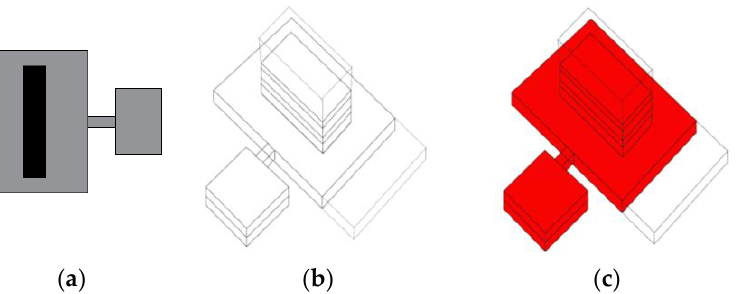
Figure 6. Tower-on-a-podium layout. ( a ) Planimetric scheme; ( b ) Axonometric scheme; ( c ) Axonometric scheme with the minimum area that must be dedicated to the infectious disease section indicated red.